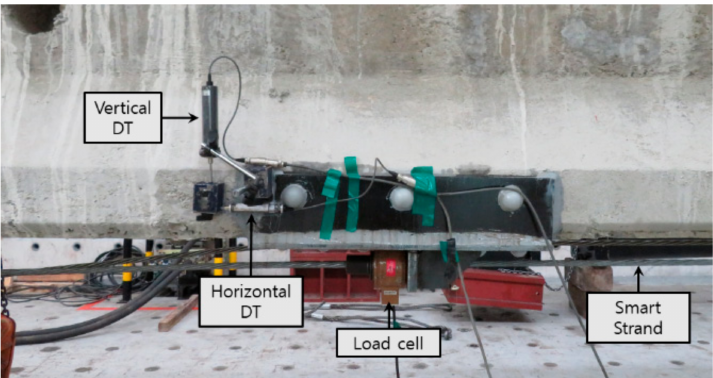
Figure 6. Anchorage sensor